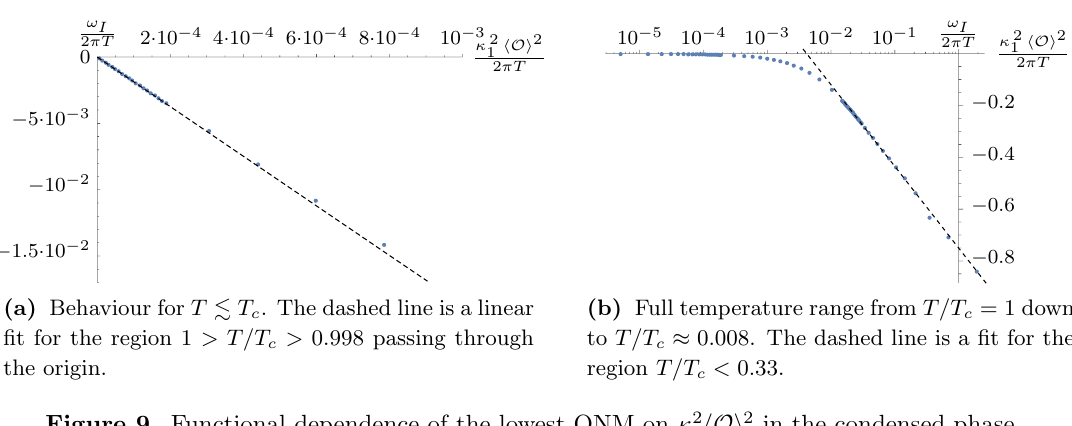
Figure 9. Functional dependence of the lowest QNM on (cid:20) 2